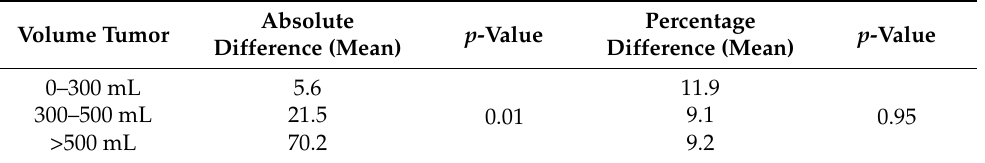
Table 4. Differences between radiological and manual segmentation volume in absolute numbers and percentages.